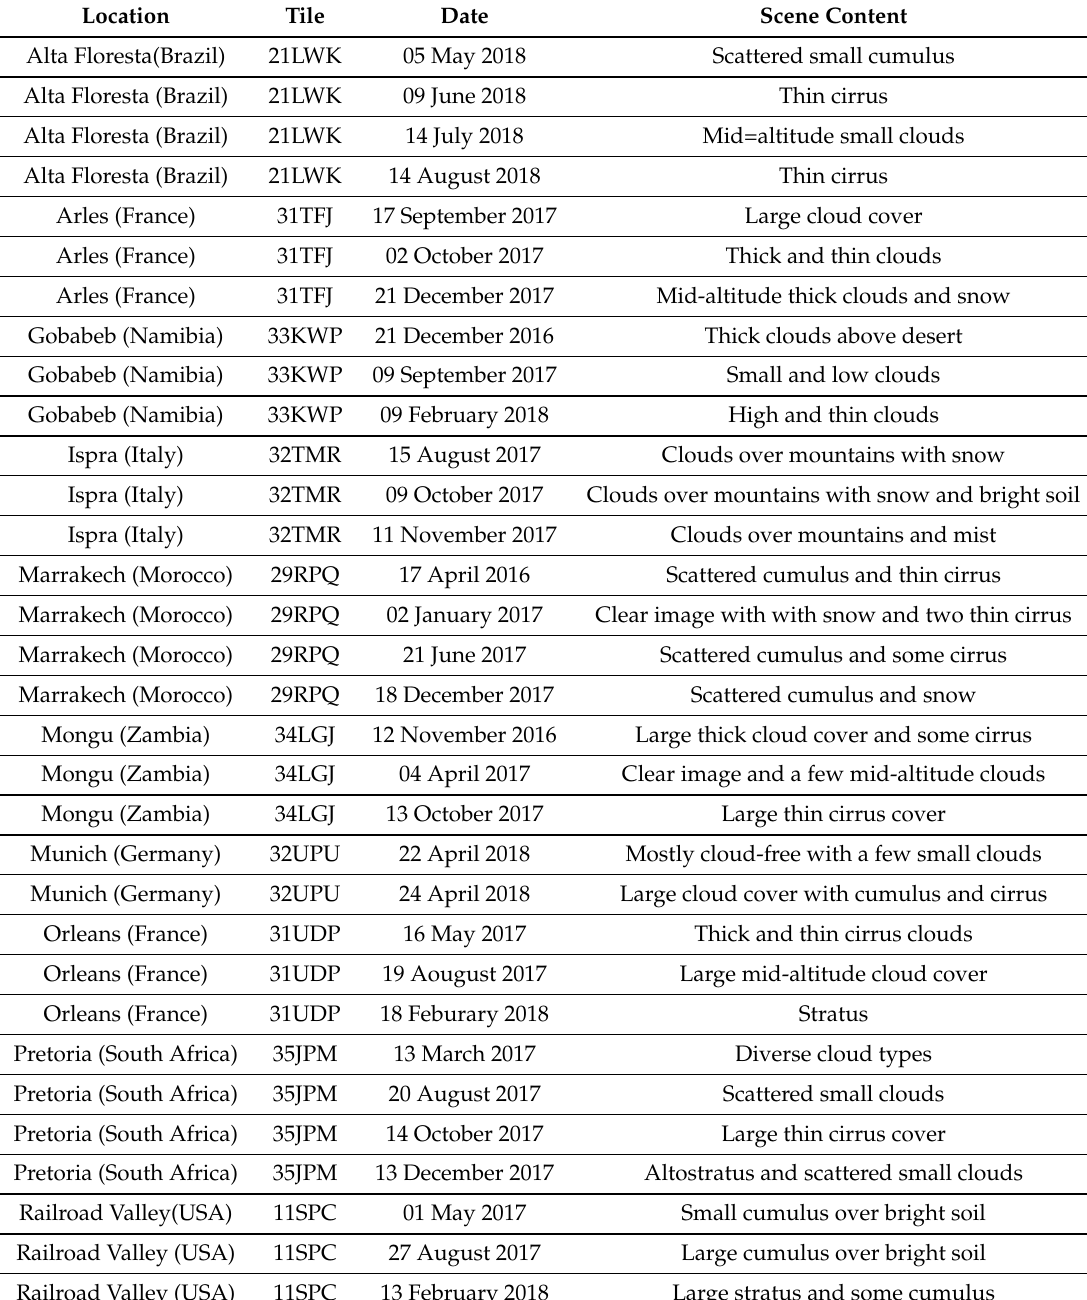
Table 1. Description of each scene used as